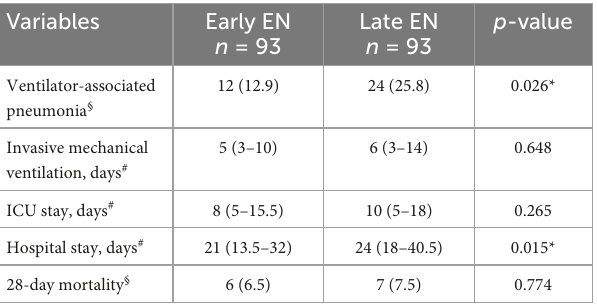
TABLE 4 Comparison of outcomes in early and late enteral nutrition groups after